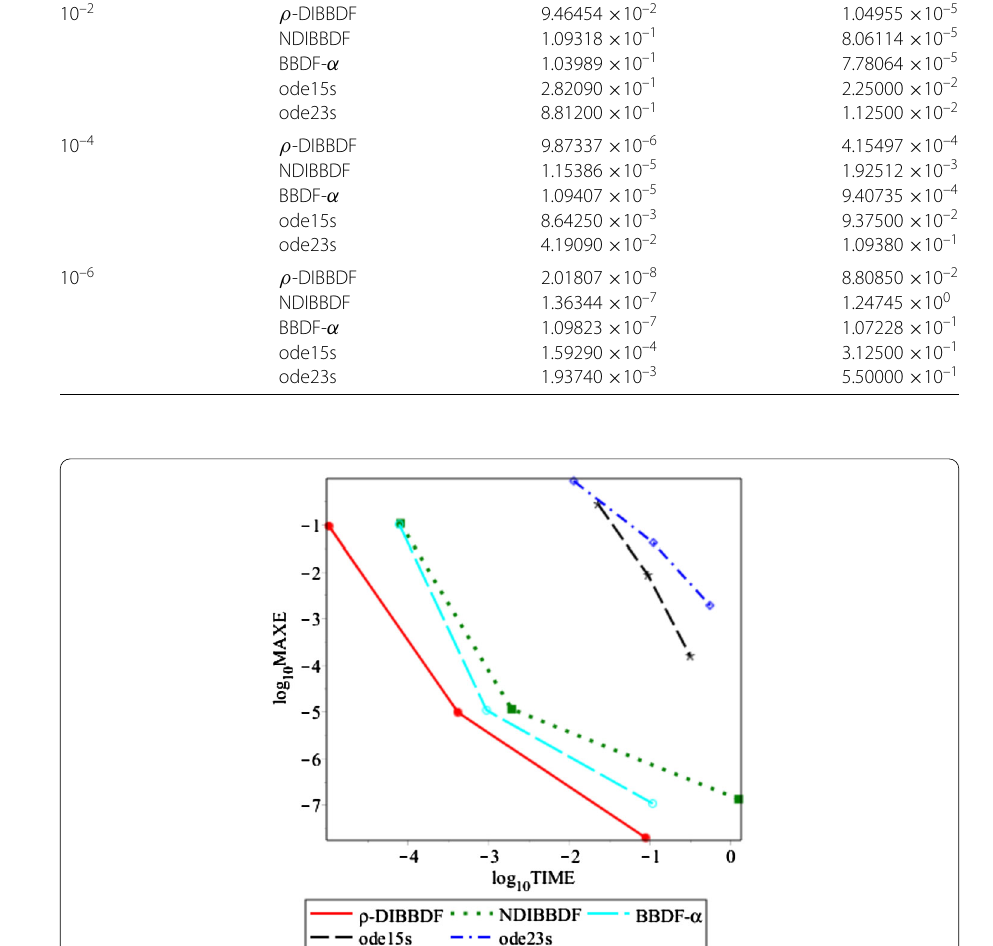
Table 10 Numerical results for concentration of drug in Model C(iii) h